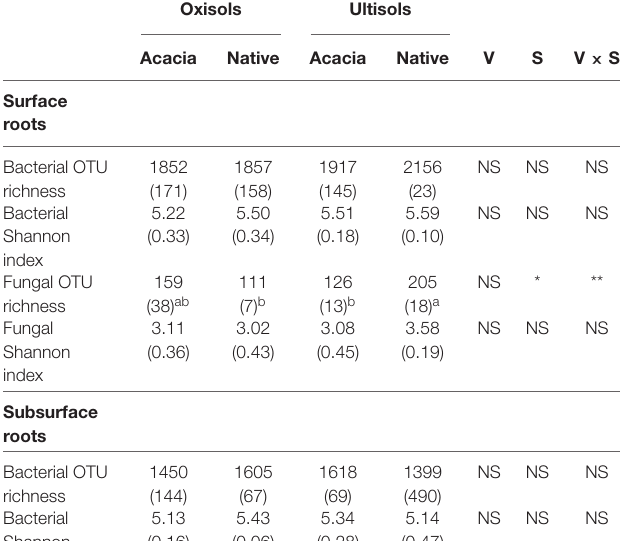
TABLE 3 | Richness and diversity index values of the bacterial and fungal communities in two vegetations (Acacia and Native; V) for two soil types (Oxisols and Ultisols;